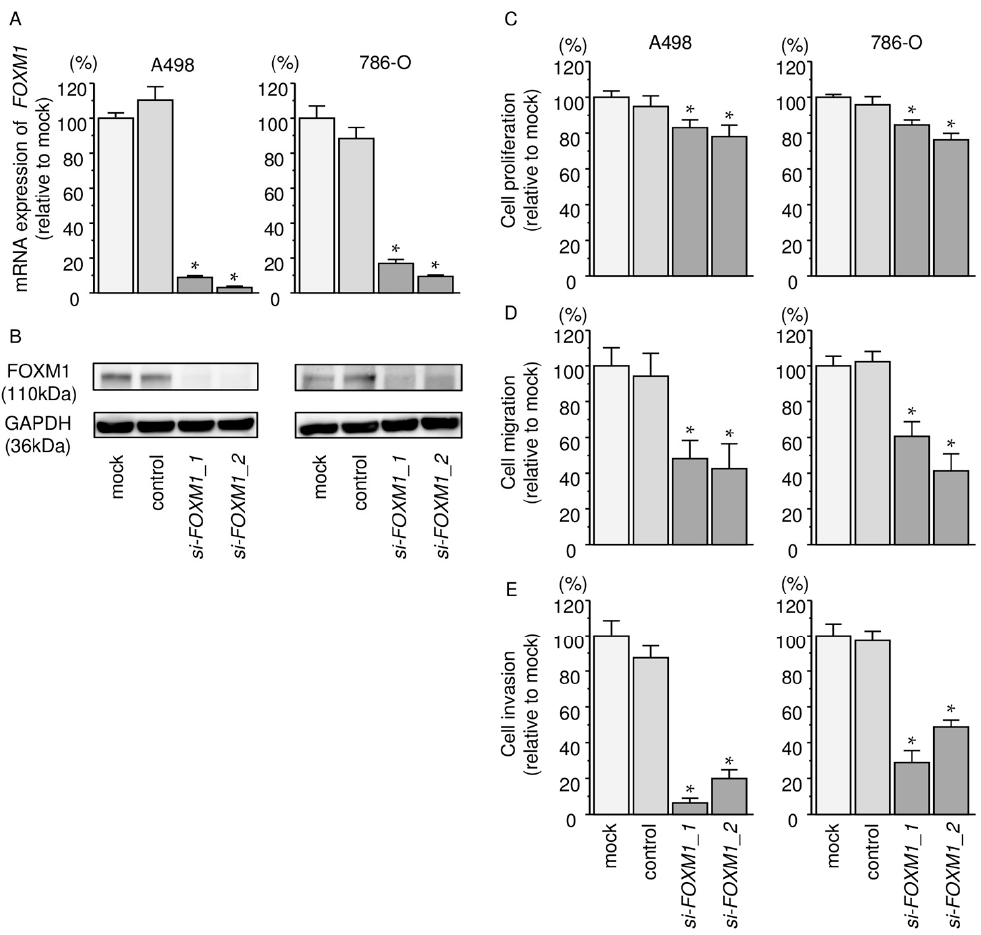
Figure 7. FOXM1 mRNA and FOXM1 protein expression after si -FOXM1 transfection and the effects of FOXM1 silencing in RCC cell lines. ( A ) FOXM1 mRNA expression in RCC cell lines was evaluated by qRT-PCR. GAPDH was used as an internal control; ( B ) FOXM1 protein expression in RCC cell lines was evaluated by Western blot analysis. GAPDH was used as a loading control; ( C ) Cell proliferation was determined using XTT assays, * p < 0.0001; ( D ) Cell migration activity was determined by wound-healing assays, * p < 0.0001; ( E ) Cell invasion activity was determined using Matrigel invasion assays. * p < 0.0001.